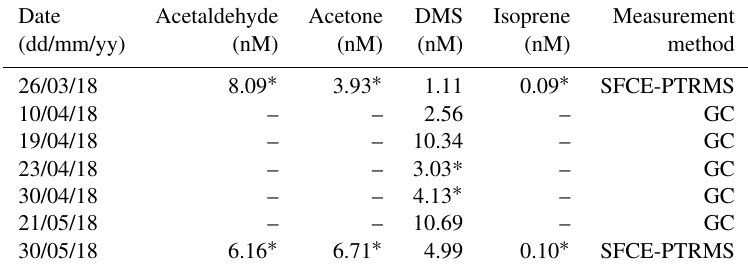
Table A4. Seawater concentrations of VOCs at the L4 marine station at 2m depth. ∗ Denotes concentration used for two-layer